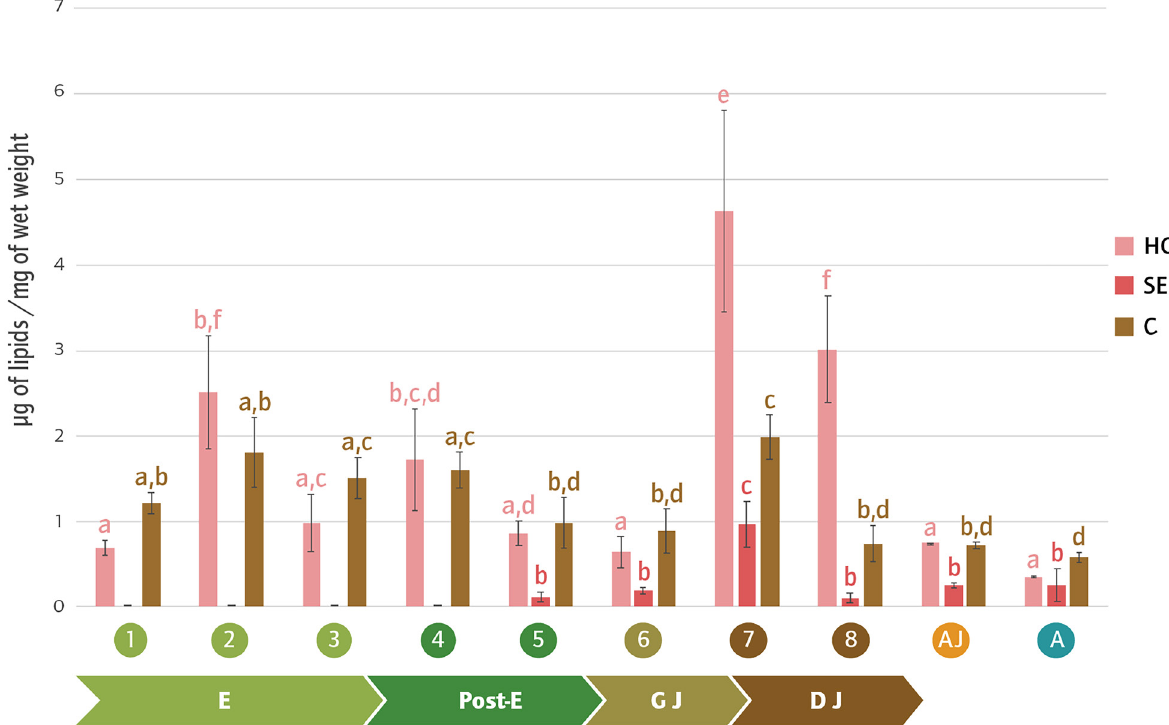
Figure 10. Concentration of modulating or signaling lipids during P. pythagoricus development until adult’s stage: hydrocarbons (HC), cholesterol (C) and sterol esters (SE). Values are the means ± SDs. Different letters above the bars indicate significant differences among the different stages at p < 0.05, as determined by Tukey’s post hoc test. 1 to 8: stages of P. pythagoricus development; AJ: advanced juvenile stage; A: adult stage; E: embryonic period; Post-E: post-embryonic period; GJ: juveniles in gregarious stage; DJ: juveniles in dispersal